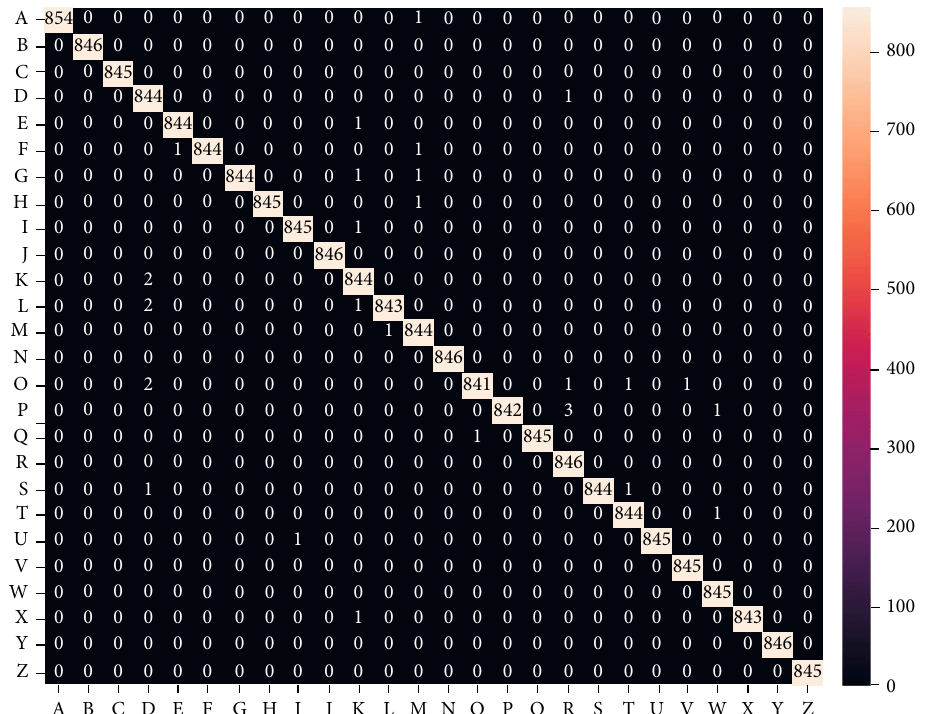
Figure 9: Confusion matrix for the Abas dataset for the proposed CNN-LSTM